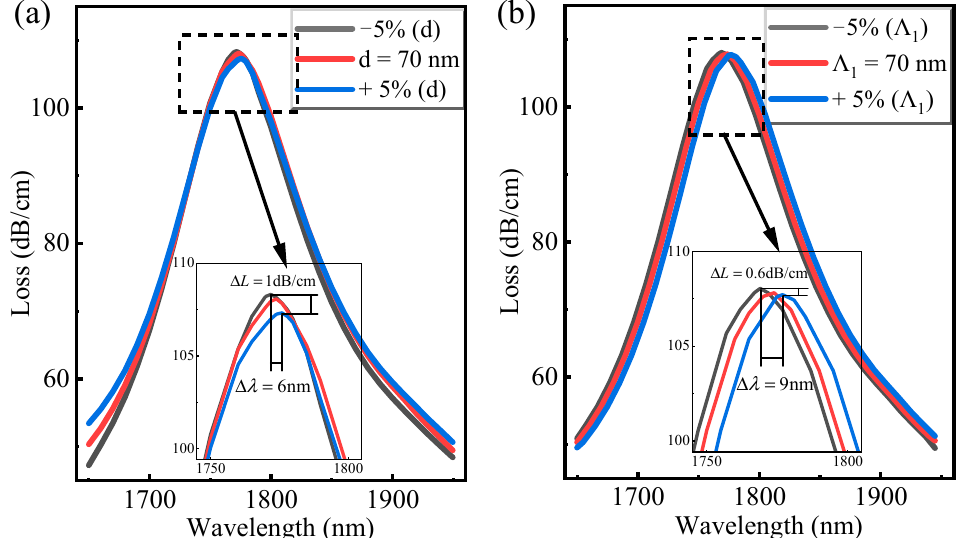
Figure 8. Manufacturing tolerance analysis. Analysis of ( a ) Au nanowires diameter and ( b ) straight spacing of Au nanowire groups.